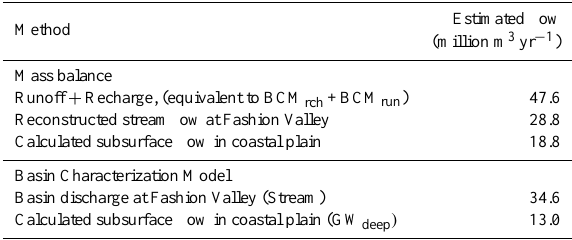
Table 7. Groundwater flow to the coastal plain of the San Diego River for the calibration period, 1982–2009, calculated using two approaches, a mass balance approach with average annual, spa- tially distributed BCM recharge and runoff accumulated for the basin from which reconstructed streamflow is subtracted, and deep groundwater flow calculated from the partitioning of BCM recharge and runoff into streamflow